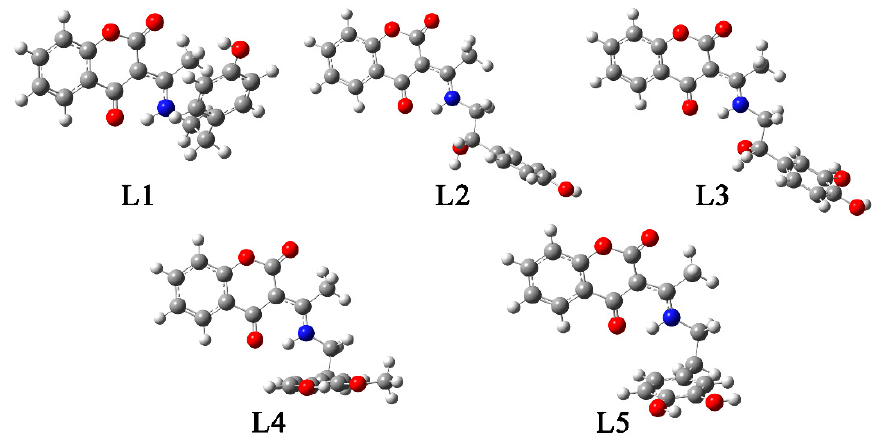
Figure 3. Optimized geometries of the coumarin-neurotransmitter derivatives (at B3LYP-D3BJ/6- 311++G(d,p) level of theory).